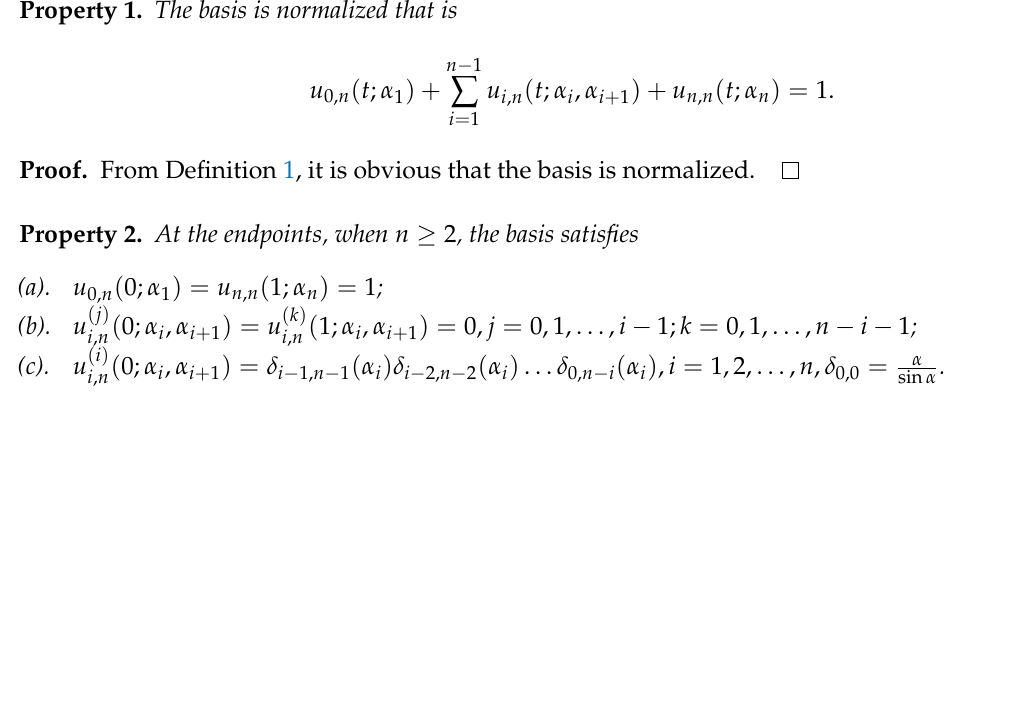
Figure 2. Cubic basis functions. ( a ) α 1 = π ( c ) α 1 = π α 1 = 13 π